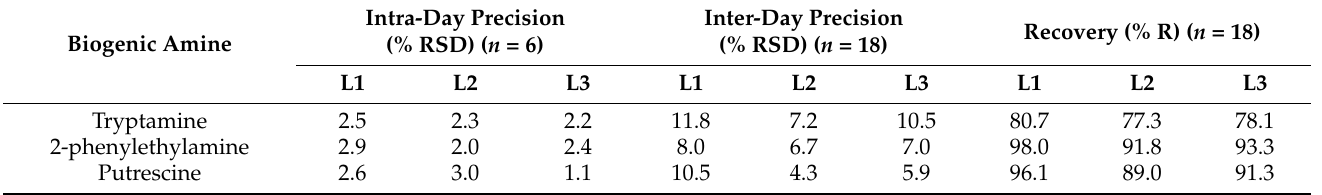
Table 4. Accuracy of biogenic amines determination in cheese at three concentration